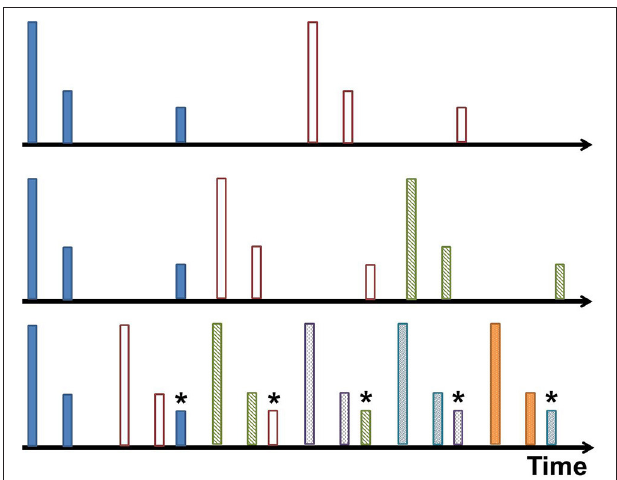
FIGURE 4 | Transducer envelope of pulses and echoes at different repetition rates demonstrating aliasing in the bottom graph. The outgoing pulse peaks at 0.4V, overlapping echoes from two closely-spaced PVC pipes are seen peaking at 0.2V, and a single loud echo made by a square poster board is seen peaking at 0.25V. The interpulse interval is decreased in each graph until a new pulse occurs before all echoes from the previous pulse are received, causing an aliasing condition where the poster board incorrectly appears at short